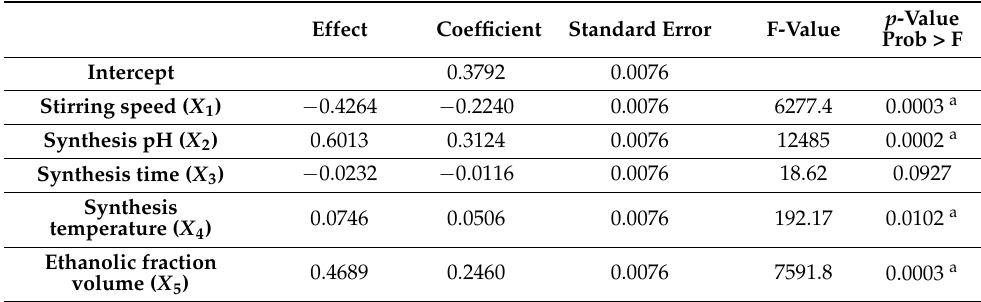
Table 3. Effects of the variables and statistical analysis of the Plackett-Burman design for AgNPs